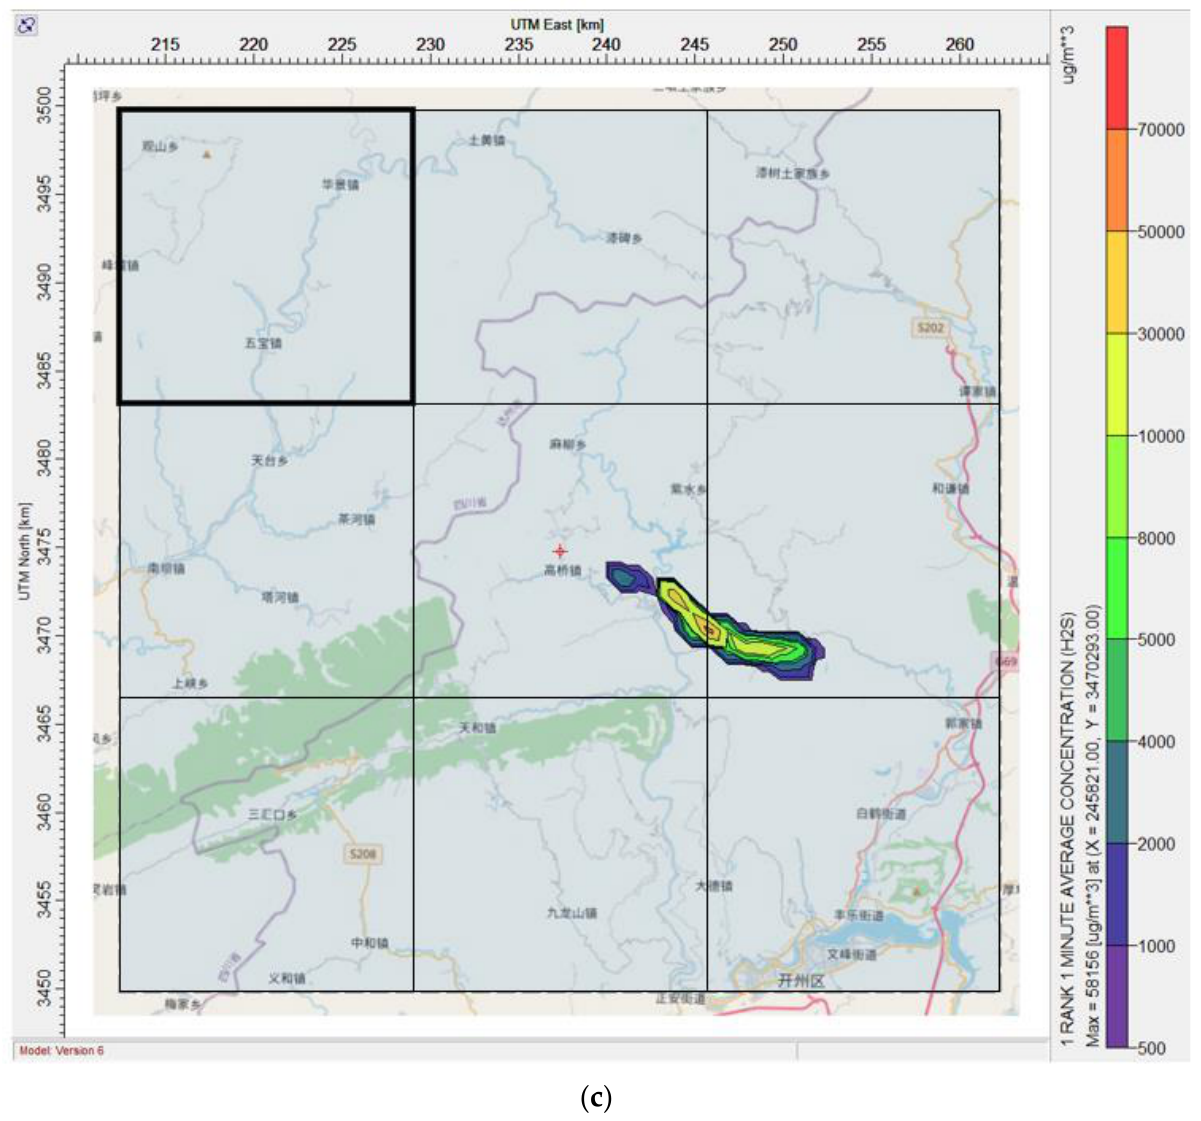
Figure 7. Simulation results for: ( a ) a buffer size of 10, ( b ) a buffer size of 20, and ( c ) the serial program. The blue squares with overlapping represent sub-areas, and the contours of the first sub-area are in bold type. The emission source is located at the red cross mark. The Chinese characters indicate the names of administrative areas (e.g. below the red cross mark is Gaoqiao Town). The unit “ug/m**3” means “ μg/m 3 ”.